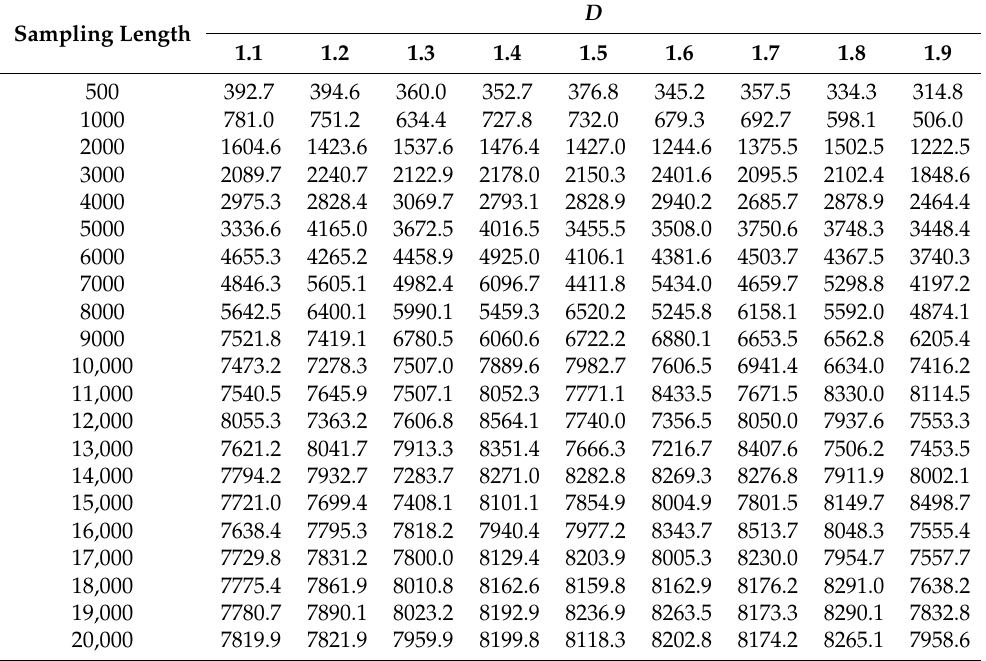
Table A3. Under all sampling lengths and all fractal dimensions, L c of corner points under the condition of 2-order flattening